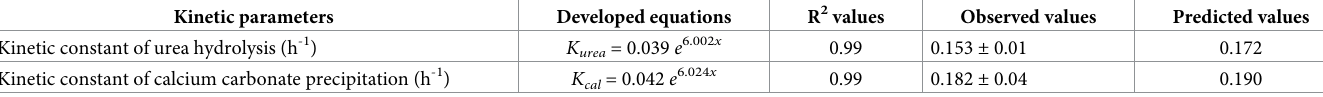
Table 4. The observed and predicted values of the kinetic parameters using the 0.25 OD as initial cell concentration. Kinetic parameters